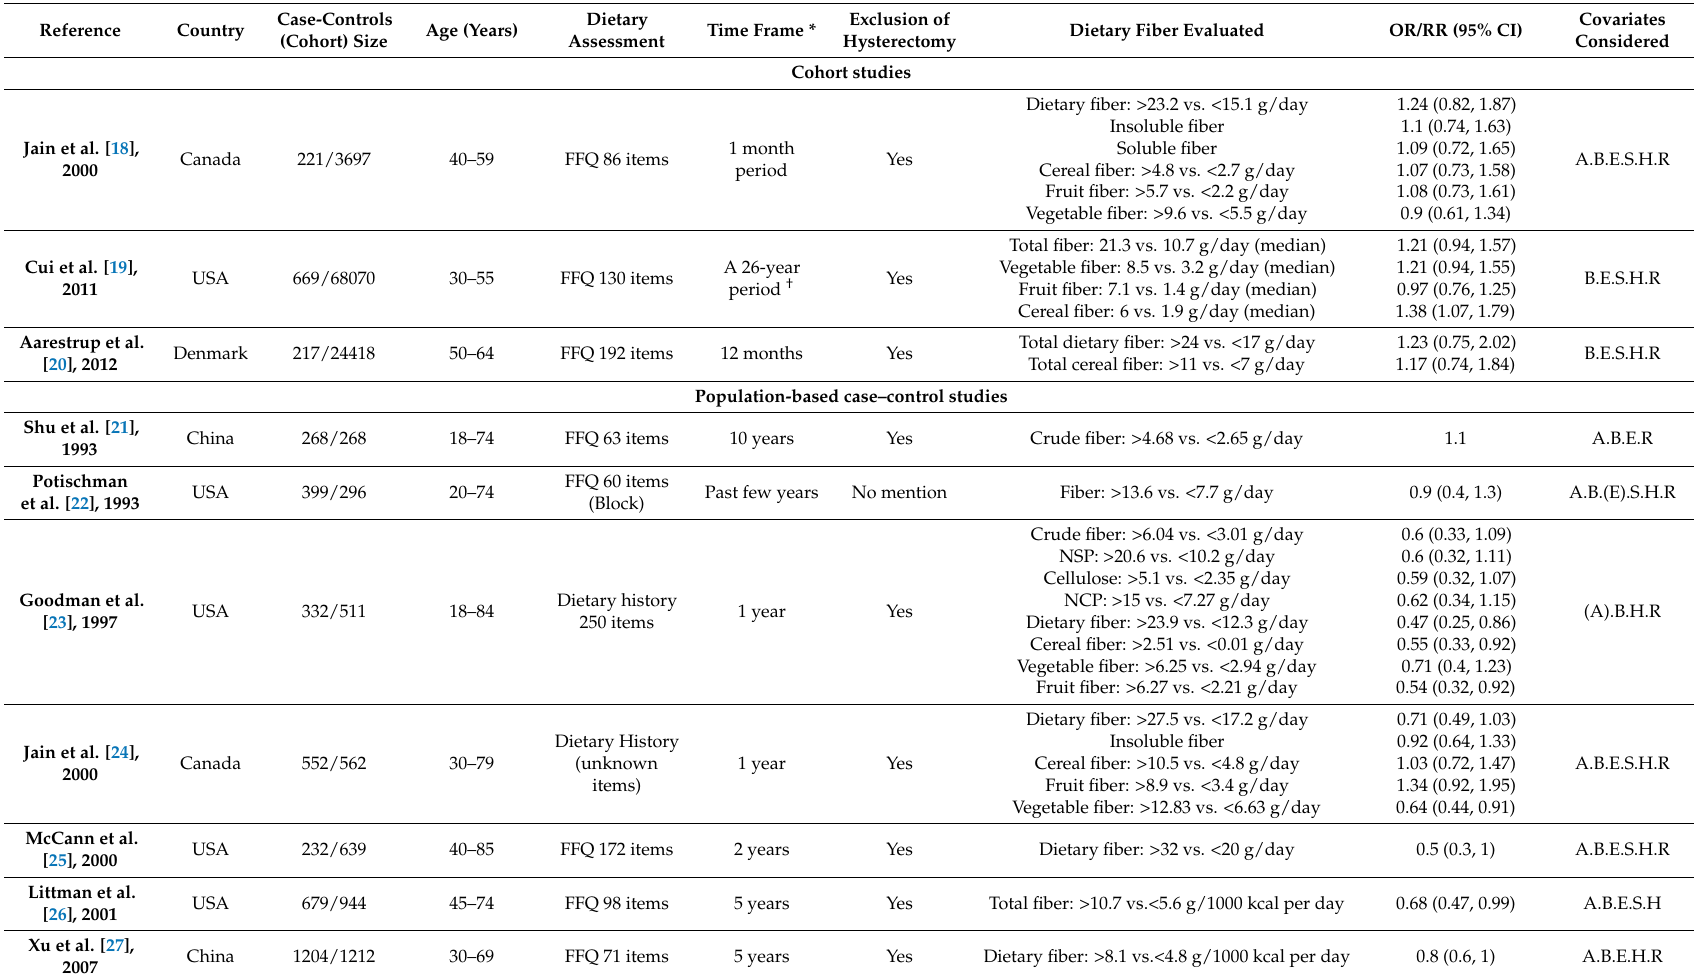
Table 1. Characteristics of studies evaluating dietary fiber and endometrial cancer